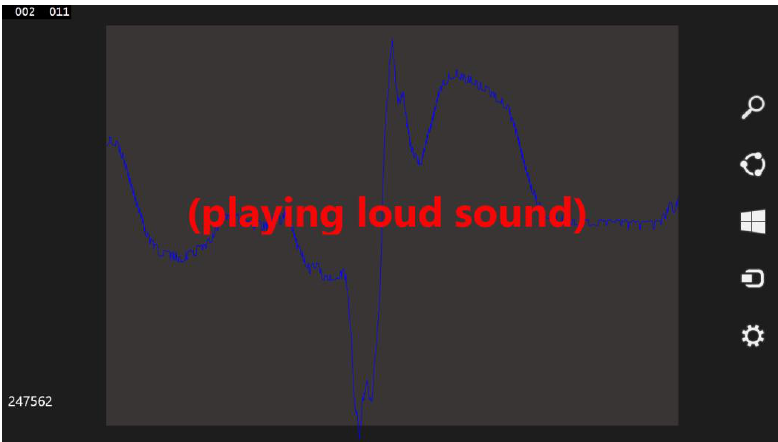
Figure 6. Tablet-dedicated software running on a virtual machine for presentation